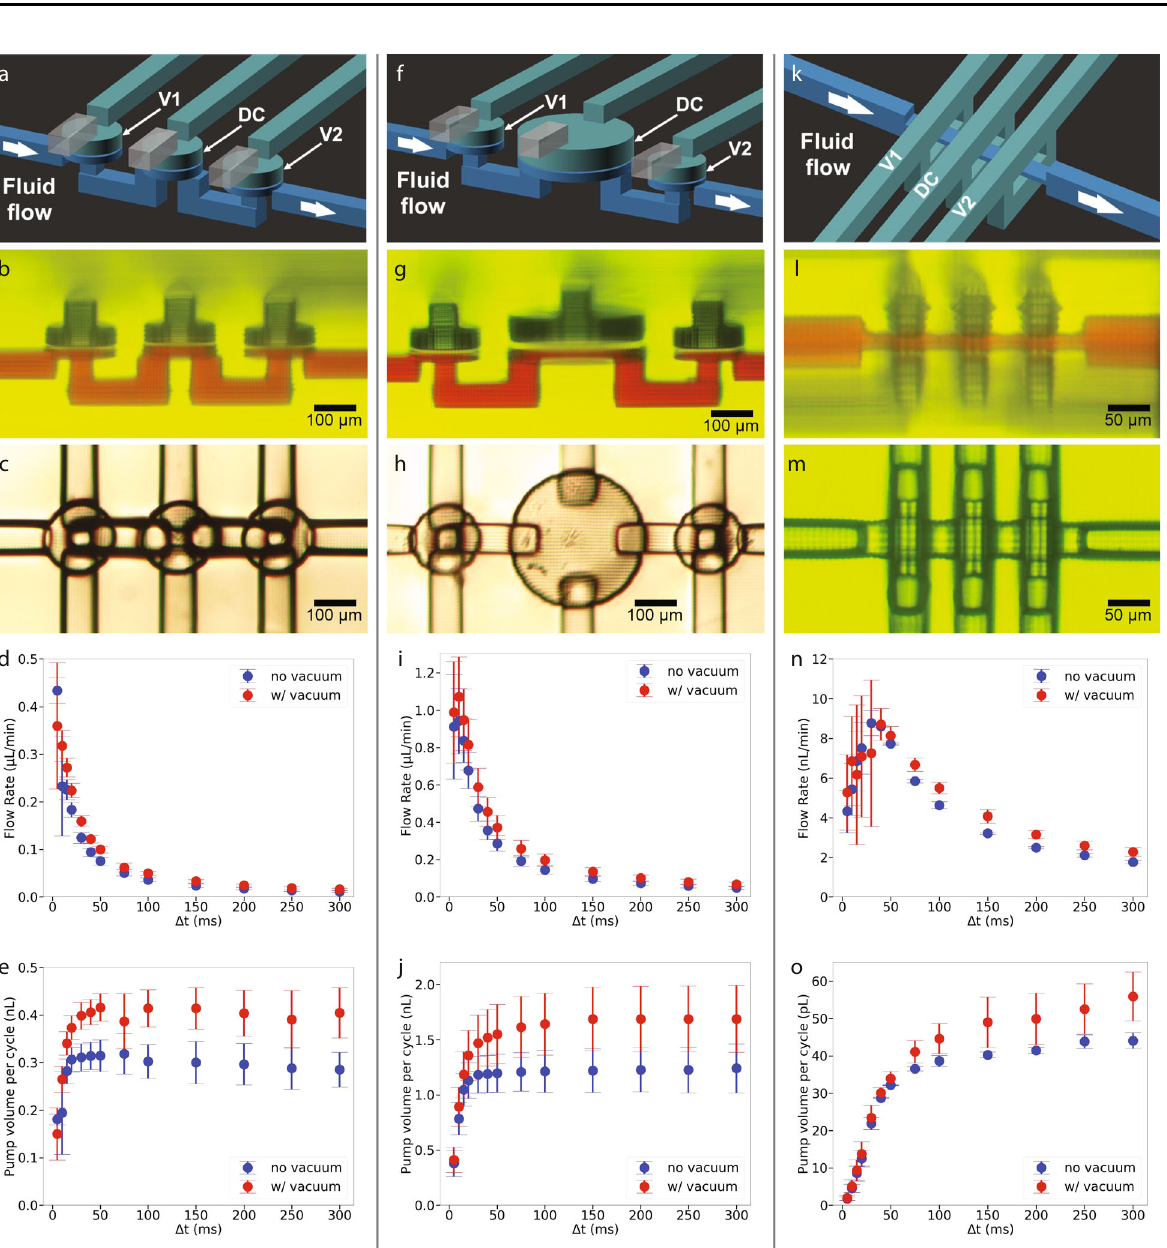
Fig. 3 3D printed membrane and squeeze valve pumps. a , f , k Schematic diagrams. b , g , l Side view microscope photos. c , h , m Bottom view microscope photos. d , i , n Volumetric fl ow rate as a function of the pump phase interval, Δ t. e , j , o Pump volume per cycle as a function of pump phase interval. All graphs were obtained from testing at least three different